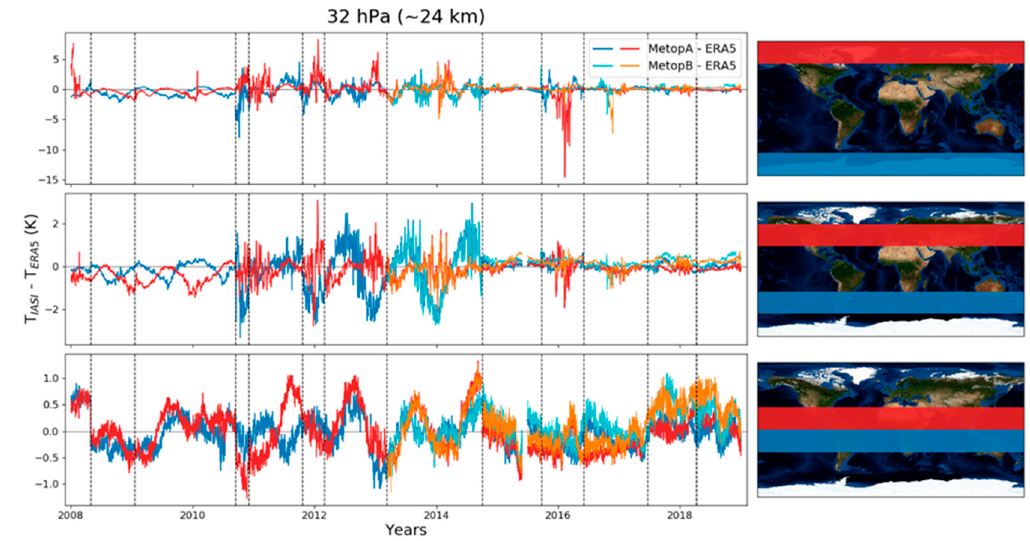
Figure 7. Differences between the IASI and ERA5 temperature at 32 hPa for Metop-A and Metop-B at the poles, mid latitudes, and equator. Note that the y-axis limit is different for the different latitude bands. The vertical dashed lines correspond to L2 updates.